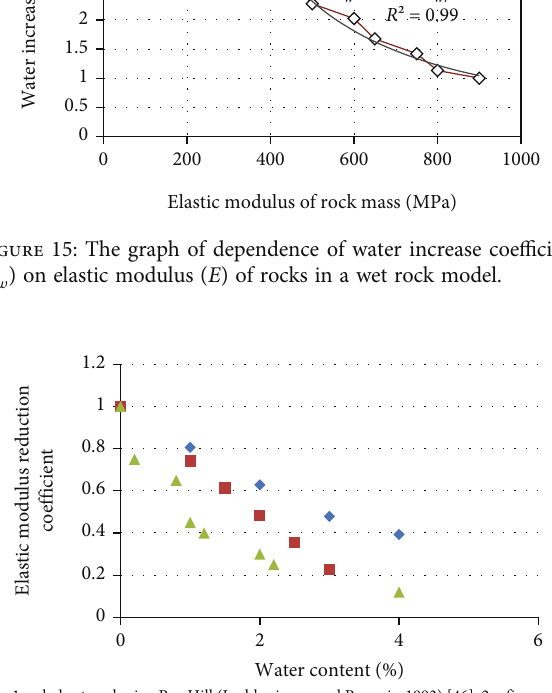
Figure 16: Elastic modulus reduction coe ffi cient ( k content ( w ).